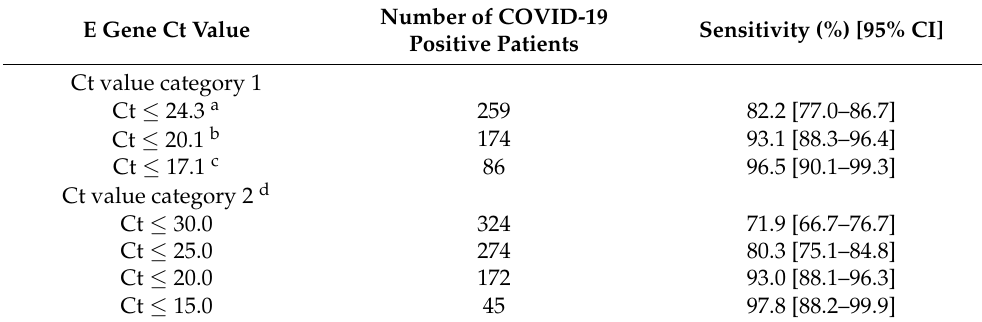
Table 3. Sensitivity of the rapid antigen test classified according to the adapted E gene Ct cutoff value of the RT–PCR in COVID-19